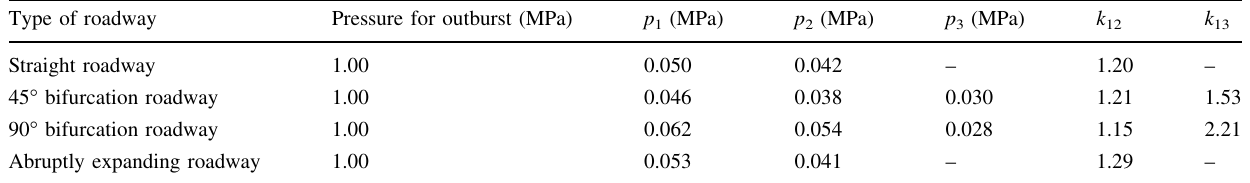
Table 2 Experimentally determined outburst attenuation coefficients for different roadway types Type of roadway Pressure for outburst